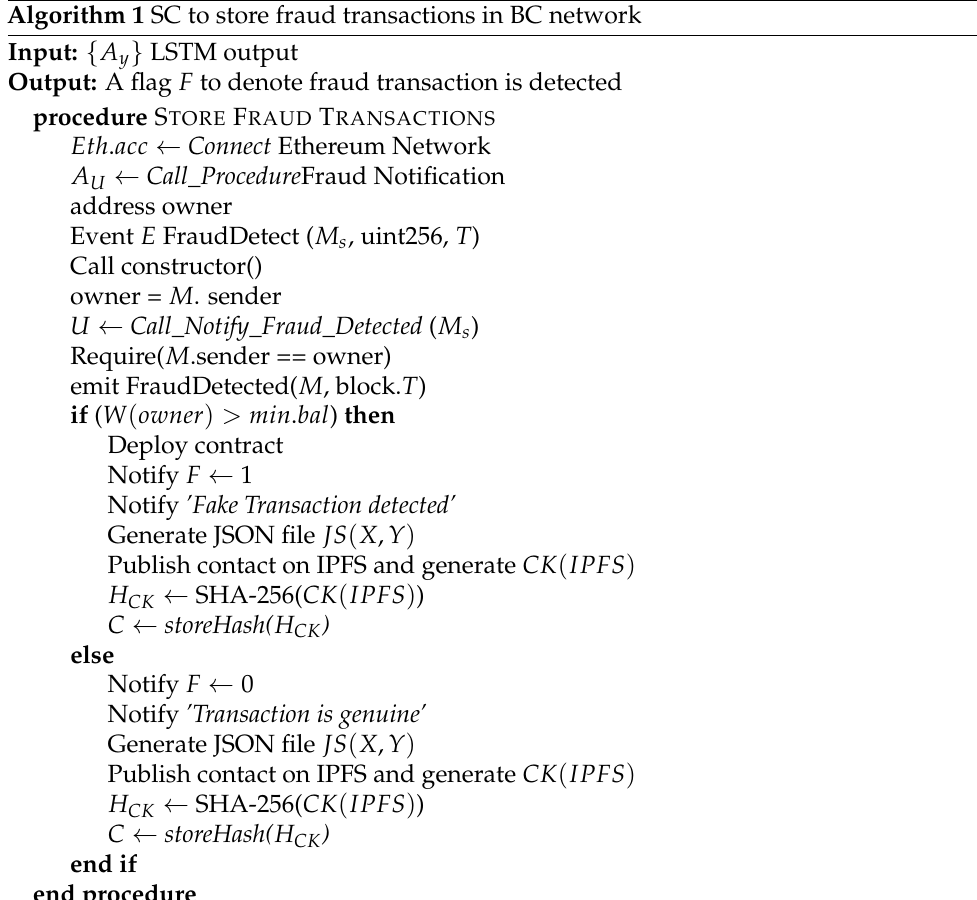
Algorithm 1 SC to store fraud transactions in BC